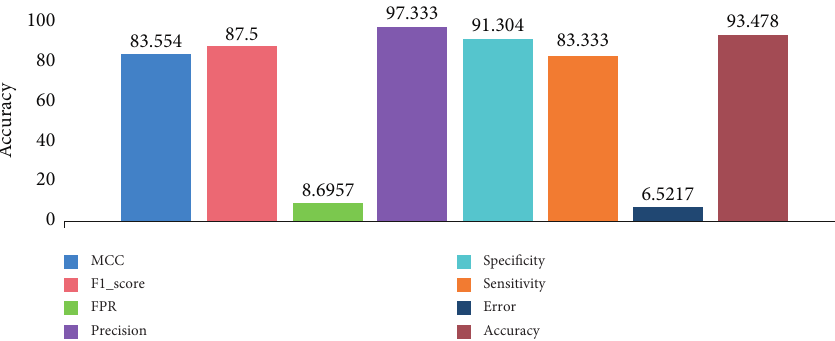
Figure 6: COVID-19 with normal and non-COVID-19 cases.